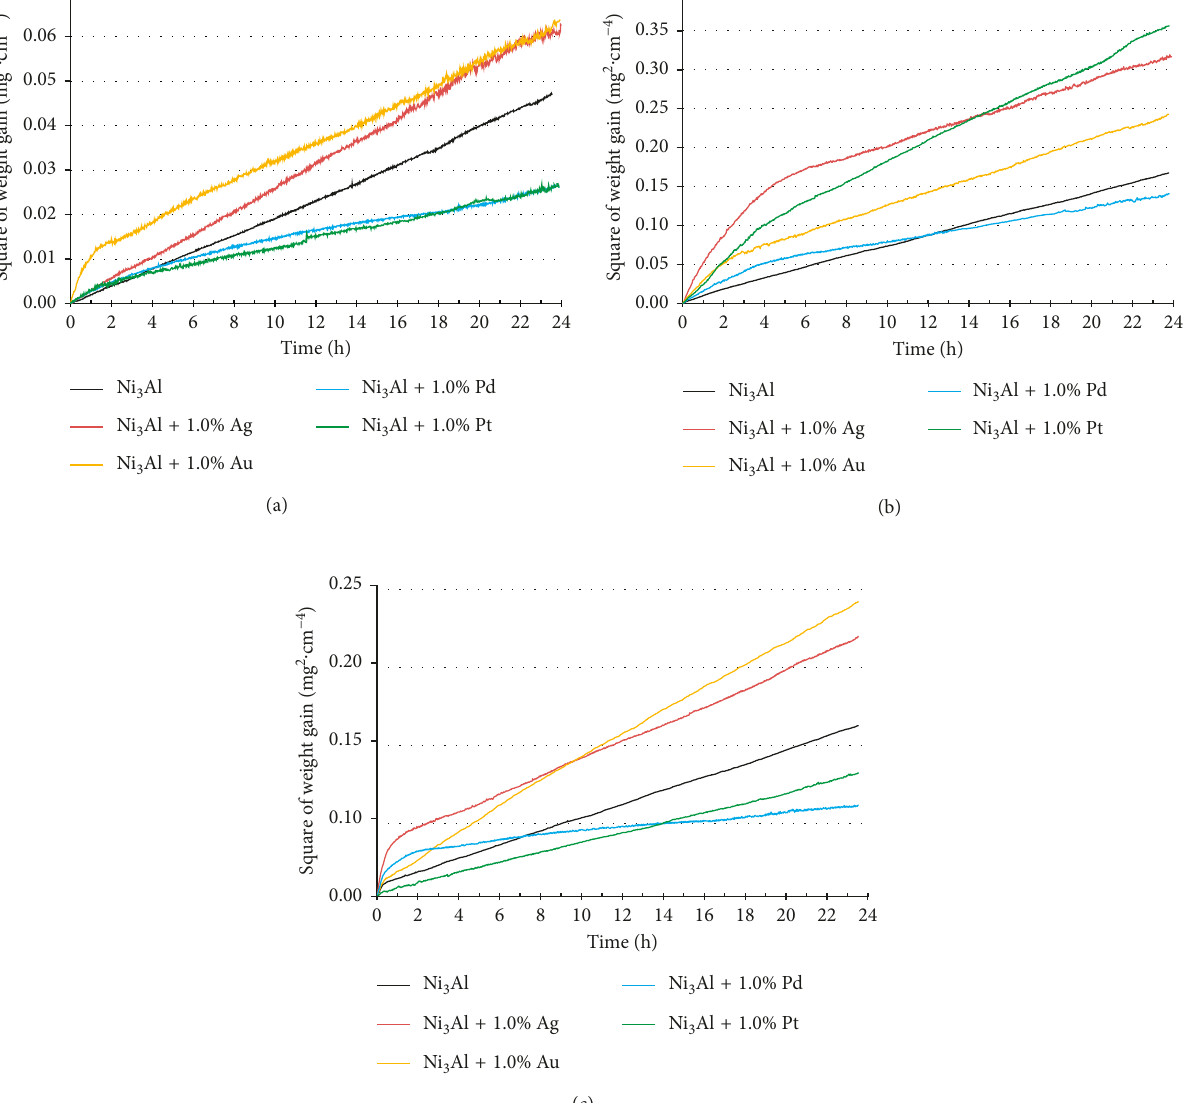
° C, (b) 1000 ° C, and (c) 1100 ° 2 at (a) 900